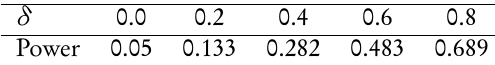
The power levels of the parametric one-sided two-sample t-test, the size of each sample is 15, and the nominal significance level is α = 0.05